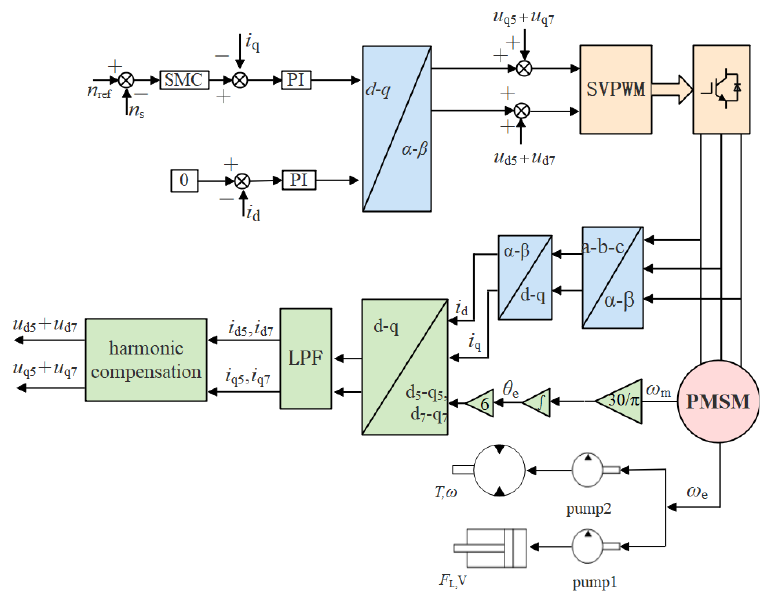
Figure 12. Functional block diagram of pump controlling the hydraulic system based on the CCSSMC-HS.